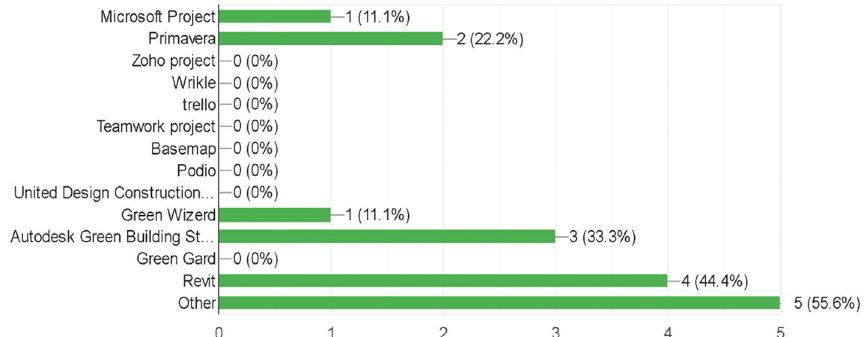
Fig. 5 The most used software programs in managing green building projects in Egypt. Ref: Researchers